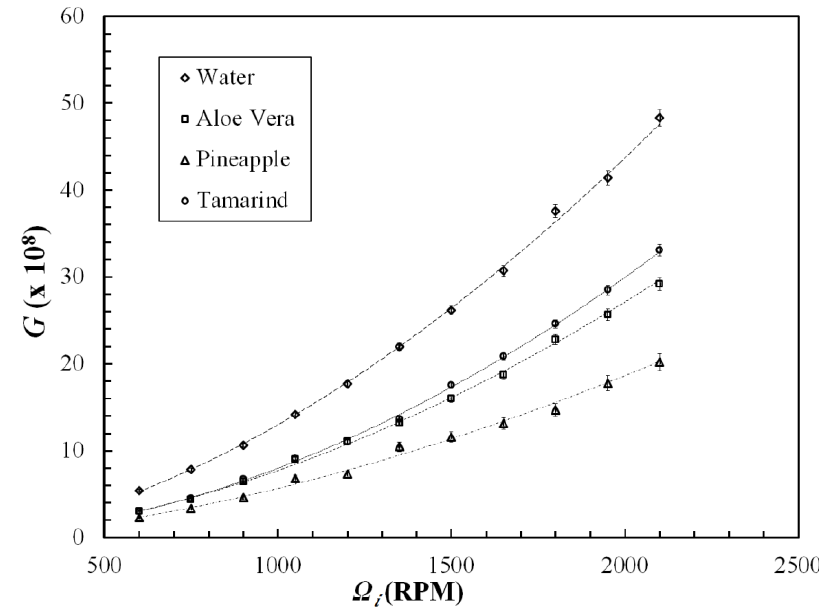
Figure 5. Dimensionless torque vs. angular velocity for polysaccharides.